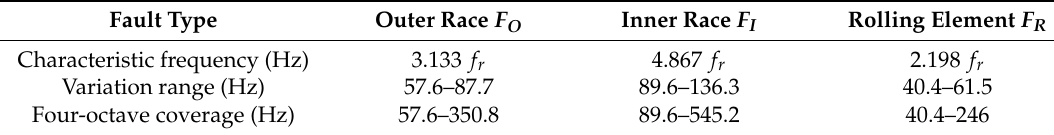
Table 2. The fault characteristic frequencies of the WTGB.